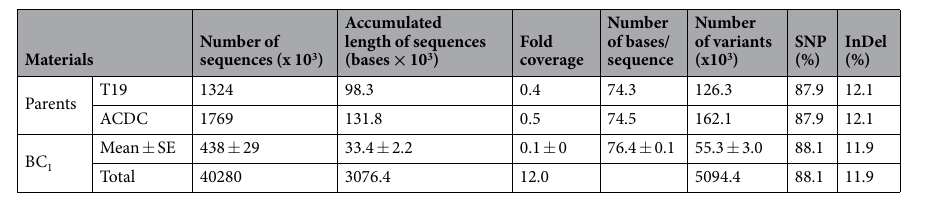
Table 2. Alignment of short reads and identification of variants in the parents and 92 BC 1 individuals.